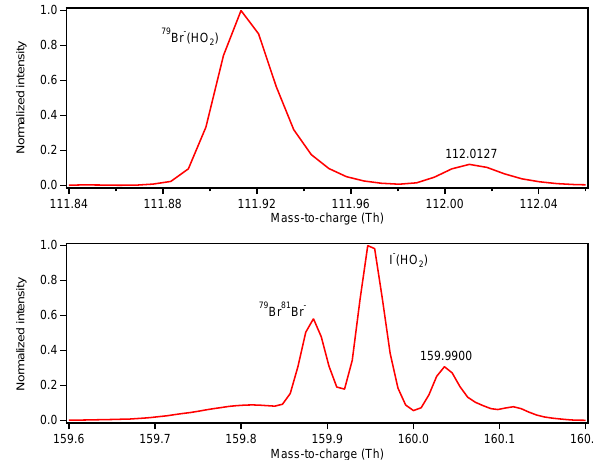
Figure 5. Comparison of laboratory generated and ambient mass Figure 6. Normalized high-resolution mass spectra of nominal spectra. Laboratory data was collected during HO 2 calibration us- m/z 112 for the Br − ionization of HO 2 (top panel) and m/z 160 ing the procedure described in Sect. 3. Ambient data from a 24h for the I − ionization of HO 2 (bottom panel). The 79 Br 81 Br − peak period during ambient sampling is shown here. The ambient mass corresponds to Br 2 added directly to the sample flow from a perme- spectrum is reversed for clarity. Few additional peaks are observed ation tube as an additional in the ambient spectrum, the majority of which are of low signal in- tensity. Prominent known peaks are at m/z 79 and 81 (Br − ) , m/z 85 (CF 3 O − ) , m/z 97 (cid:0) 79 Br − (H 2 O) (cid:1) , m/z 99 (cid:0) 81 Br − (H 2 O) and − ) . 79 Br − (HF) (cid:1) , m/z 101 (cid:0) 81 Br − (HF) (cid:1) , and m/z 113 (CF 3 COO